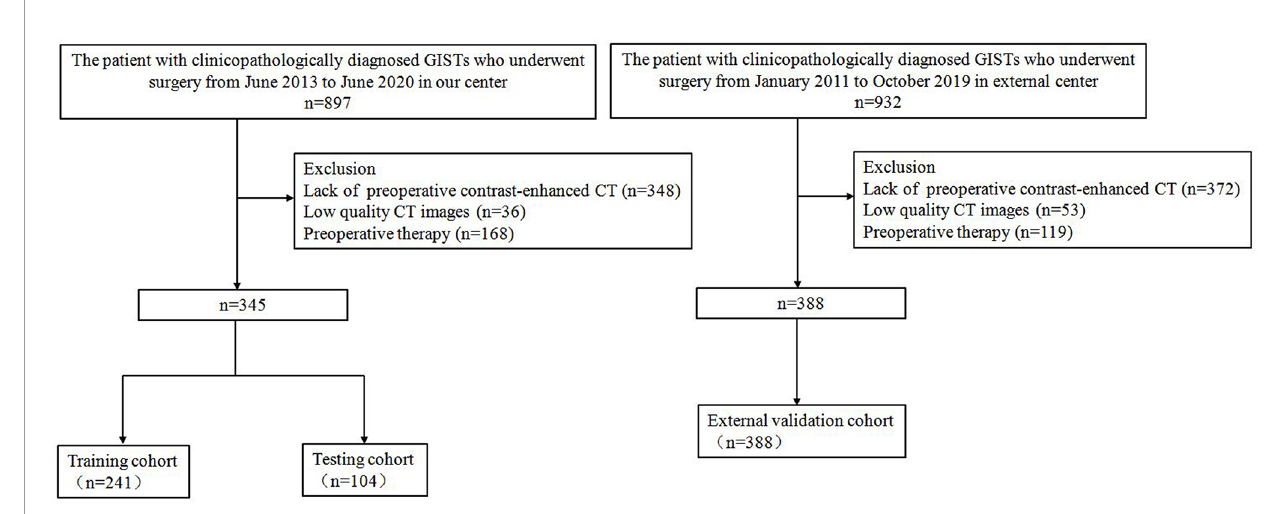
FIGURE 1 | Flow chart of patient inclusion and